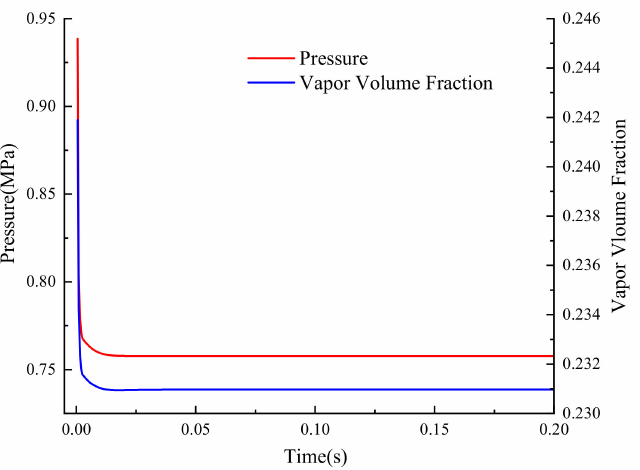
Figure 12. Local cavitation fraction and